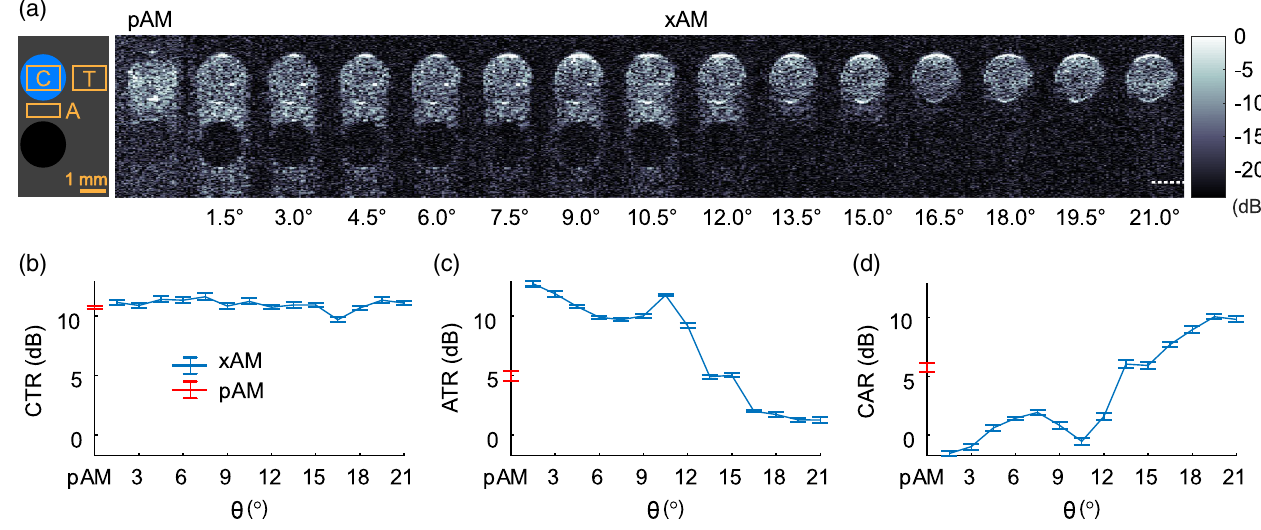
FIG. 5. In vitro pAM and xAM images of a hGV inclusion in a tissue-mimicking phantom. (a) Left panel: Schematic of the phantom configuration. The linearly scattering tissue-mimicking medium is shown in gray, the hGV inclusion in blue, and the anechoic agar-filled inclusion in black. ROIs are shown for contrast (C), tissue (T), and artifact (A) quantification. Right panel: Set of pAM and xAM images of a representative well positioned at z ¼ 4 mm. Separate images spanning depths of 3 mm to 9 mm are concatenated. Scale bar: 1 mm. White dotted line: Z X at θ ¼ 21 °. (b) CTR as a function of θ . (c) ATR as a function of θ . (d) CAR as a function of θ . N ¼ 6 . Error bars: standard error of the mean